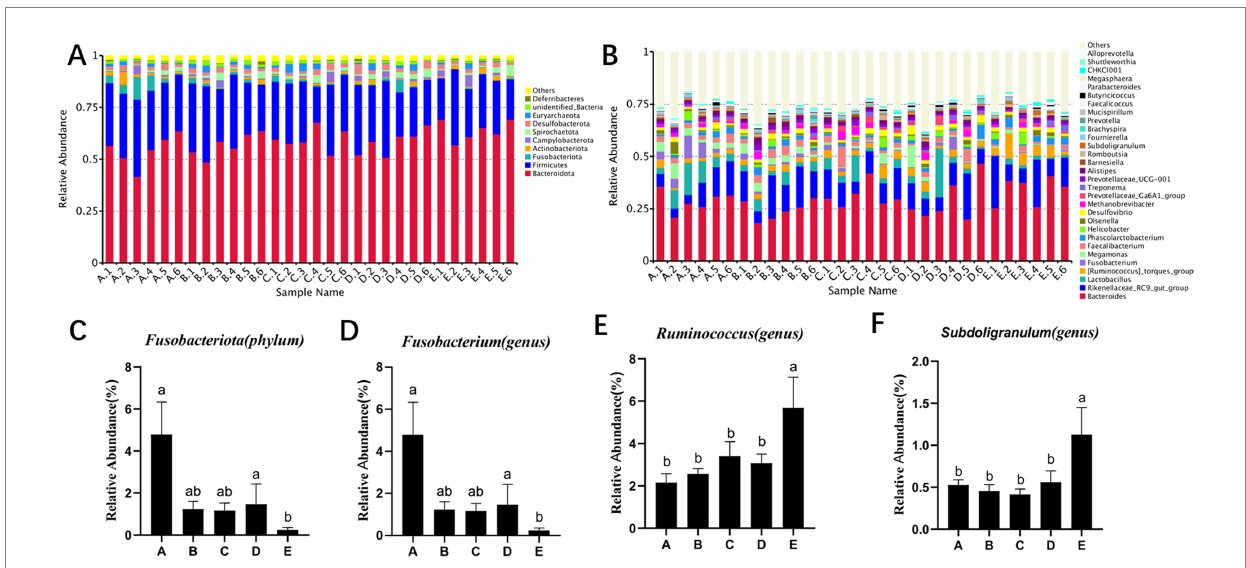
FIGURE 2 The relative abundance of cecal microbiota in laying hens fed the 5 experimental diets at the phylum level (top 10, A ) and genus level (top 30, B ). (C–F) shows the changes in 4 district genera in the gut microbiota composition of laying hens, including Fusobacteriota (phylum), Fusobacterium (genus), Ruminococcus (genus), and Subdoligranulum (genus). Six replicates (birds) were analyzed in each treatment ( n = 6). Group A (A.1-A.6): 0 g/t rare earth diet; Group B (B.1-B.6): 150 g/t rare earth diet; Group C (C.1-C.6): 300 g/t rare earth diet; Group D (D.1-D.6): 450 g/t rare earth diet; Group E (E.1-E.6): 600 g/t rare earth